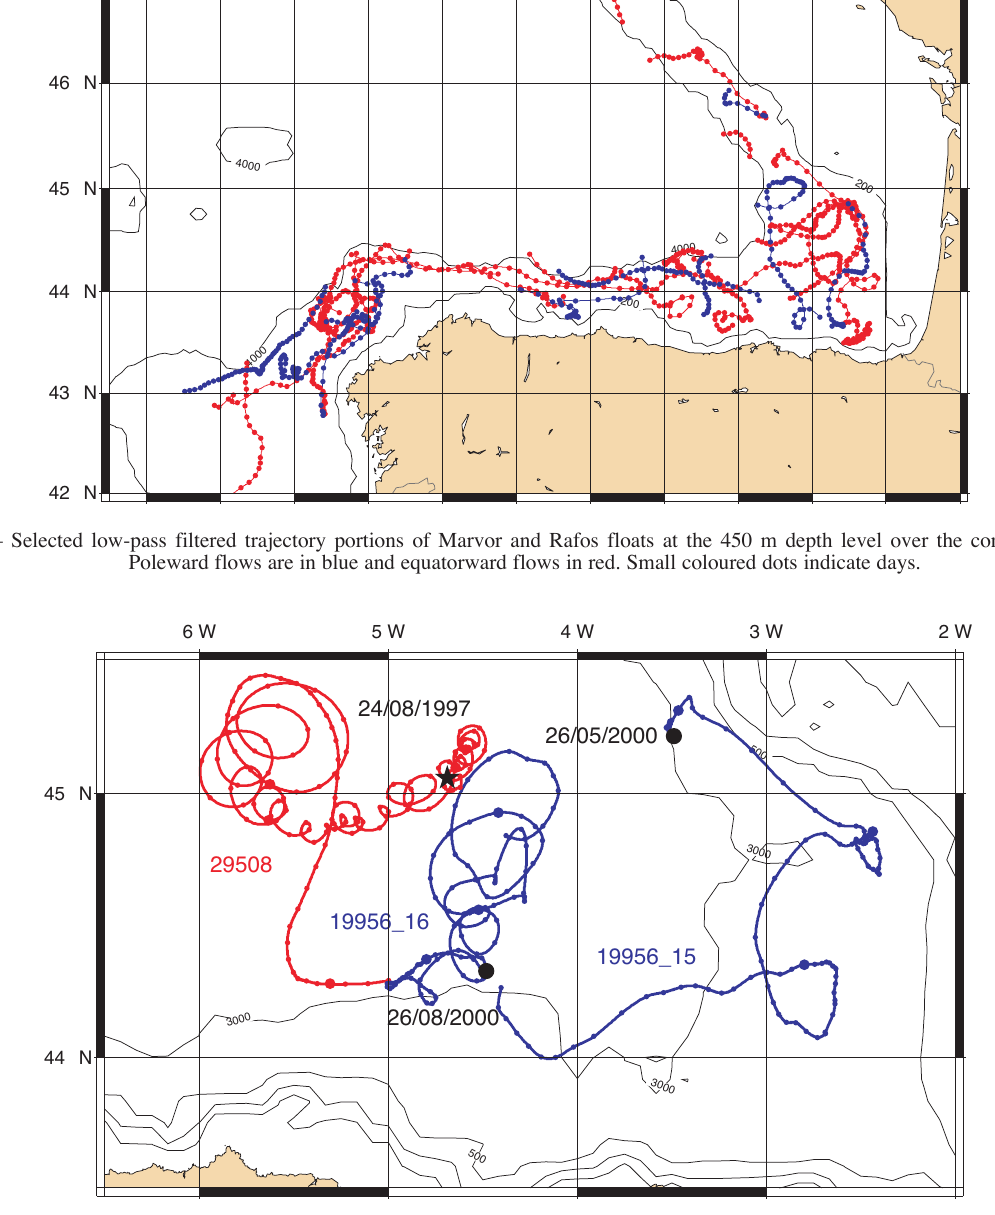
on 26 August 2000 (indicated by black dots). Small coloured dots indicate days and unlabeled bigger coloured dots indicate beginning of months. Near the middle of the eddy trajectory, some inconsistencies seem to appear, but are probably linked to uncertainties in acoustic positioning rather than a real physical